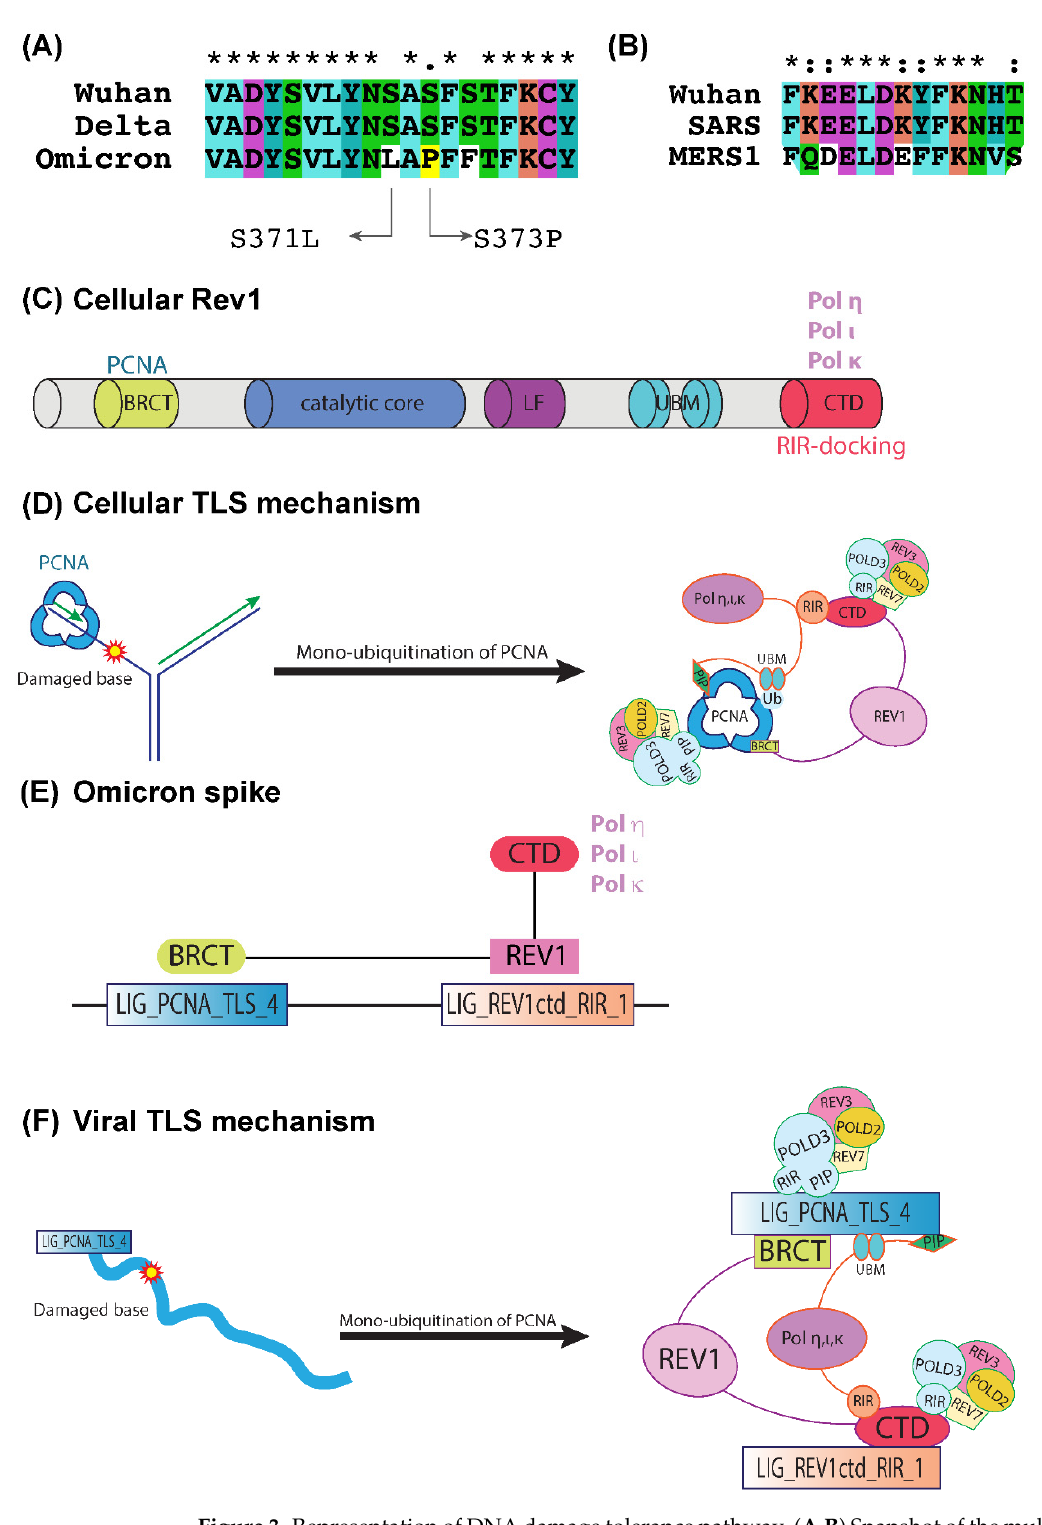
Figure 3. Representation of DNA damage tolerance pathway. ( A , B ) Snapshot of the multiple sequence alignment of spike proteins from Wuhan, Delta, and Omicron along with the specific mutations in the Omicron that lead to the emergence of SLiMs. ( C ) Schematic illustration of the domain structure of human Rev1. ( D ) Interactions of human Y ‐ family polymerases in TLS. ( E ) Omicron SLiMs LIG_REV1ctd_RIR_1 and LIG_PCNA_TLS_4 interact with human REV1. ( F ) LIG_REV1ctd_RIR_1 and LIG_PCNA_TLS_4 motif involvement in the viral TLS.